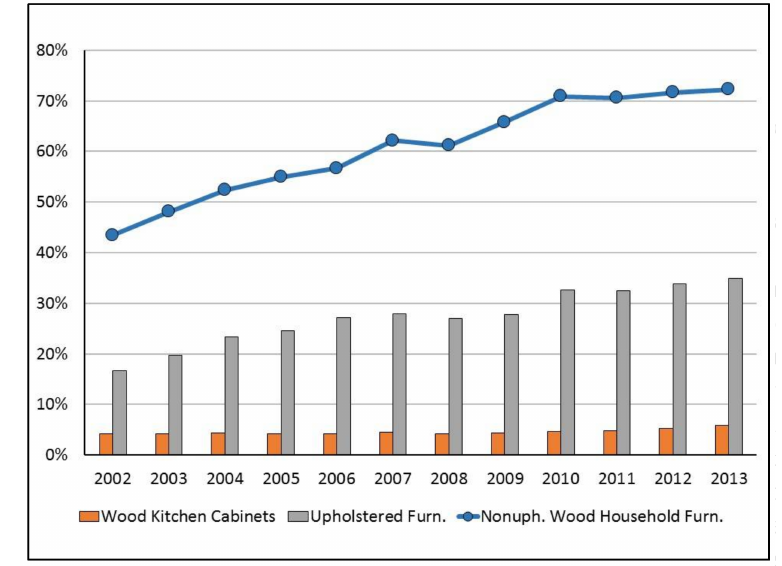
Figure 1. Estimated import market shares in the wood household furniture, upholstered